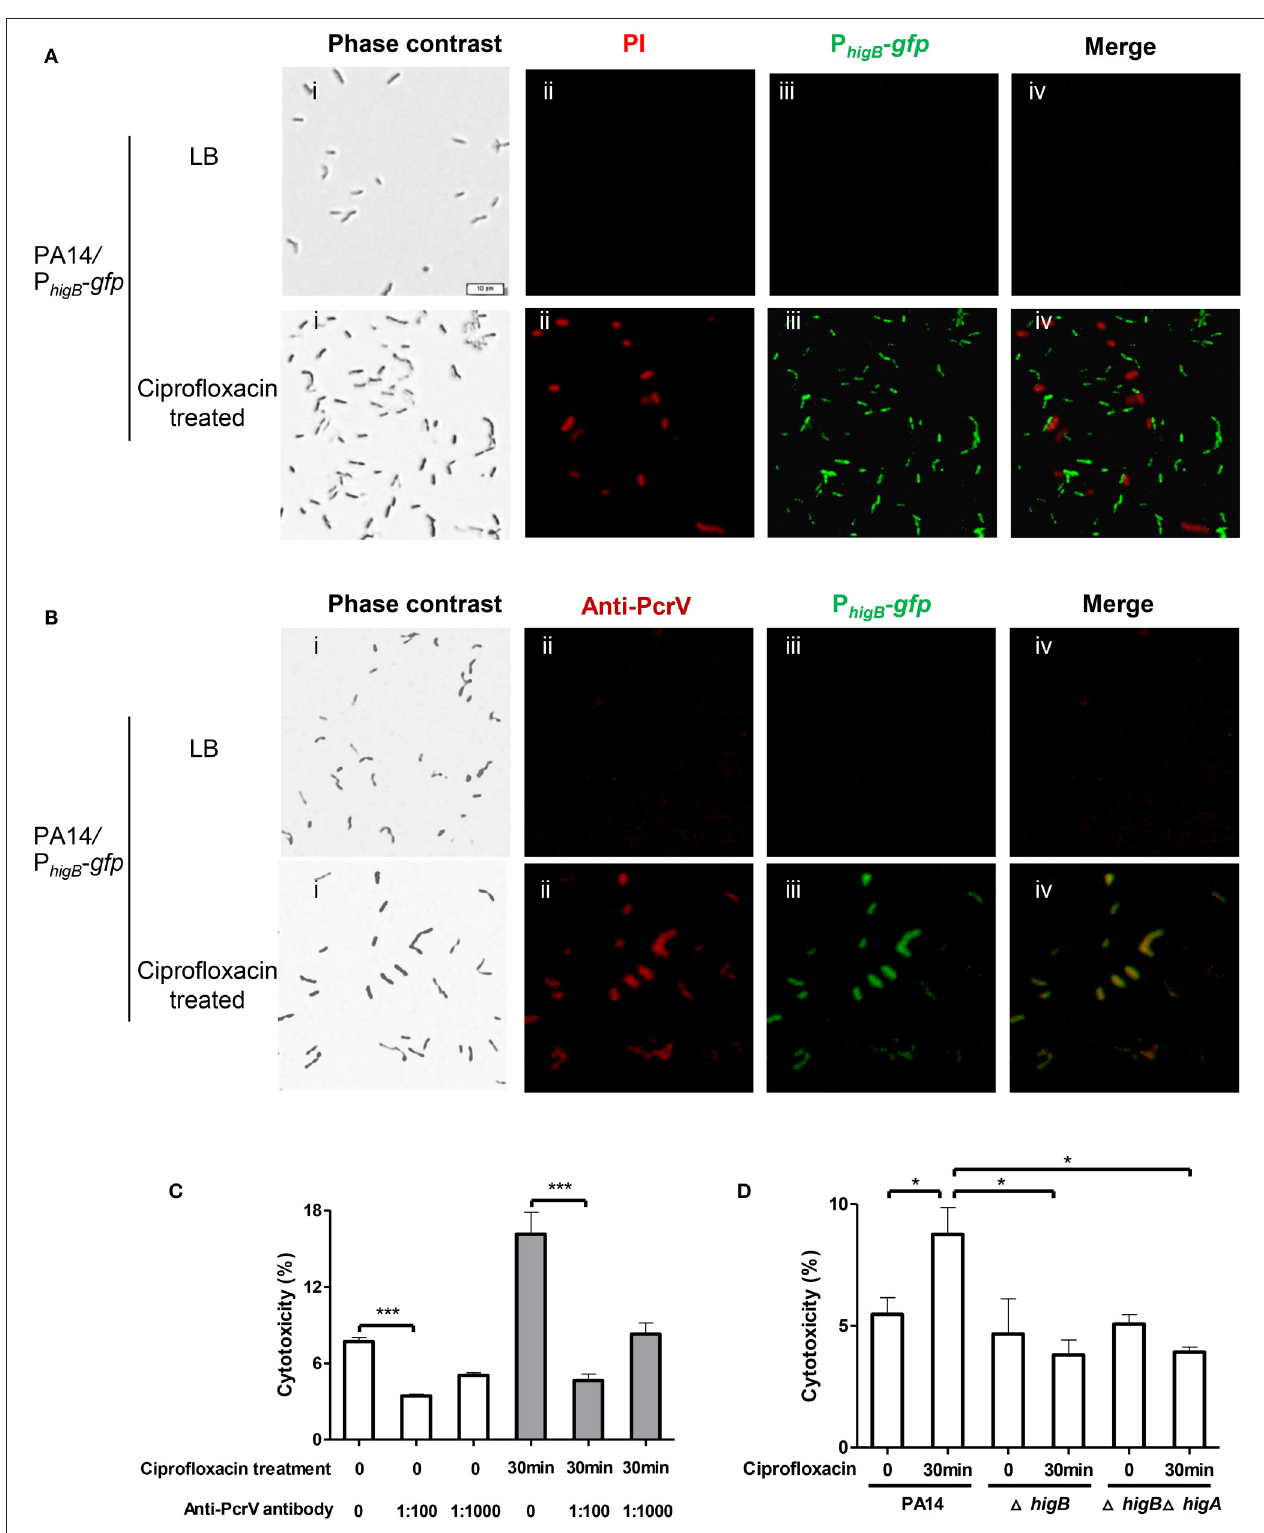
FIGURE 5 | Levels of HigB, PcrV and cytotoxicity of bacterial cells that survived ciprofloxacin treatment. PA14/P higB - gfp was cultured in the presence of 0.025 µ g/ml ciprofloxacin for 2h and then treated with 0.125 µ g/ml ciprofloxacin for 30 min. The bacteria were washed with PBS twice, stained with